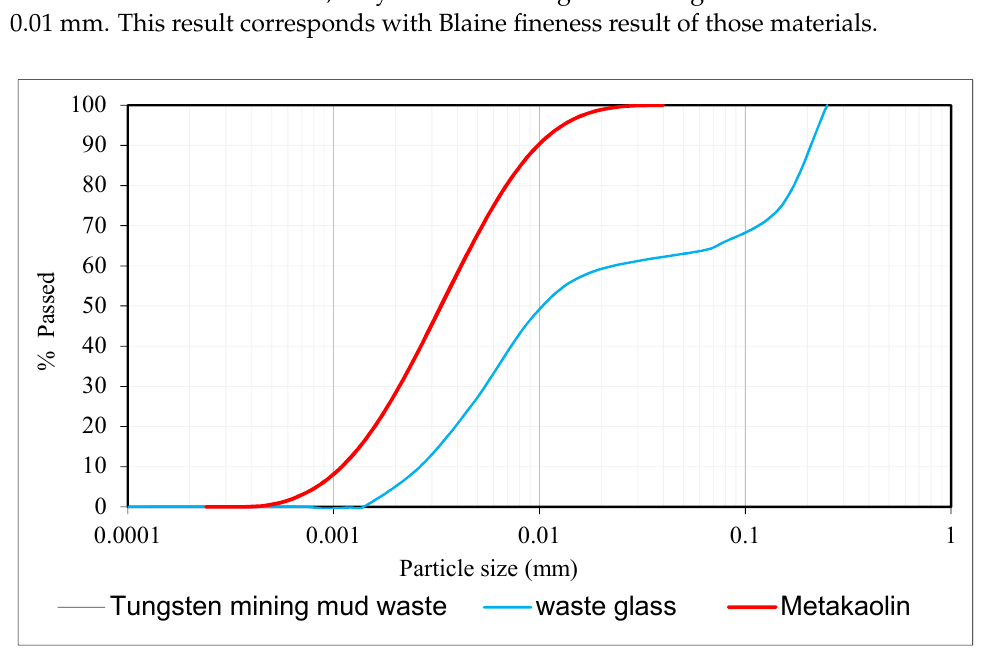
Figure 1. Particle size distribution of TMWM, WG and MK.